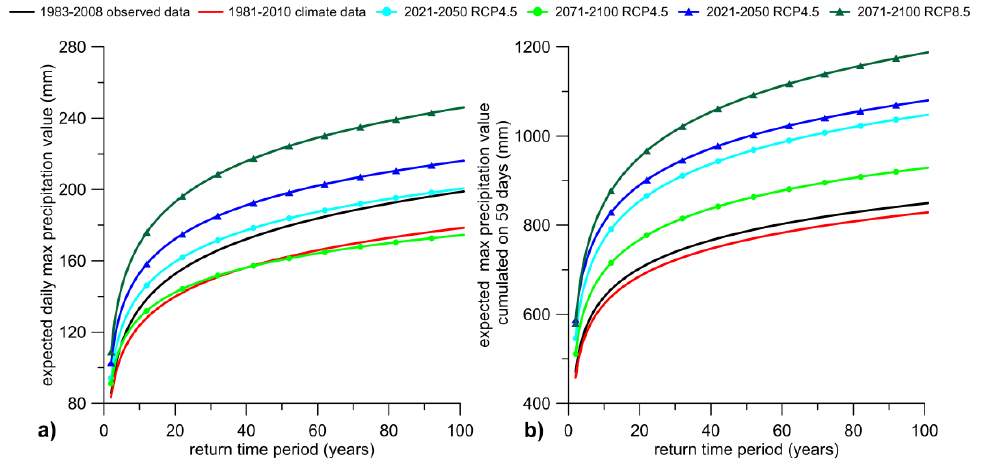
Figure 9. ( a ) expected daily max precipitation as a function of the return time period evaluated using the GEV approach on the observed data (black), bias corrected CSC on 1981–2010 (red), 2021–2050 RCP4.5 (light blue), 2071–2100 RCP4.5 (dark blue), 2021–2050 RCP8.5 (light green), 2071–2100 RCP8.5 (dark green); ( b ) the same for 59 cumulative days.